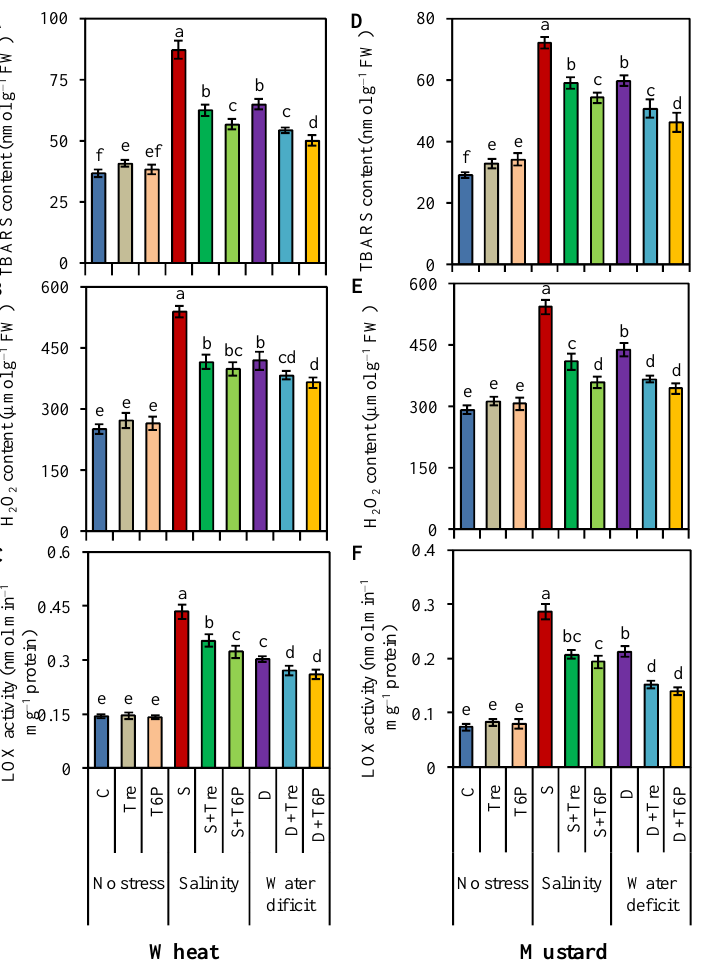
Figure 2. Effect of trehalose and T6P on TBARS, H 2 O 2 , and LOX activity in wheat and mustard seedlings. Wheat seedlings were grown in a hydroponic solution containing 300 mM NaCl for 9 days. Mustard seedlings were grown in 200 mM NaCl for 10 days. For water deficit treatment, wheat seedlings were treated with 20% PEG, while mustard was treated with 12% PEG for four days. C, control; ( A – C ) wheat; ( D – F ) mustard; Tre, 200 µ M trehalose;T6P, 200 µ M trehalose 6-phosphate; S, NaCl treatment; D, water deficit treatment with PEG 6000. Means were calculated from three replicates for each treatment, and the bars represent the standard deviation ( ± SD). Values with different letters are significantly different at p ≤ 0.05 by Fisher’s LSD